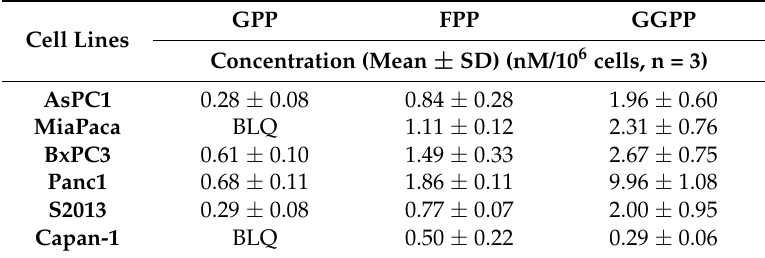
Table 5. The concentrations of IsoP endogenous compounds in human pancreatic cancer cell